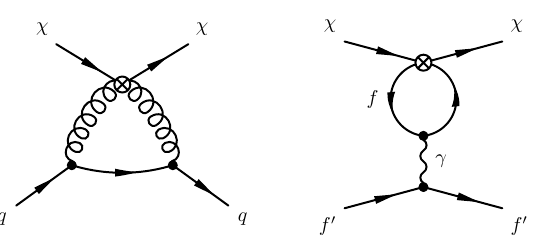
Figure 13 . Left panel: the mixing of the gluonic operators into operators with scalar and pseu- doscalar quark currents. Right panel: the mixing of dimension-six four-fermion operators into each other via the photon penguin